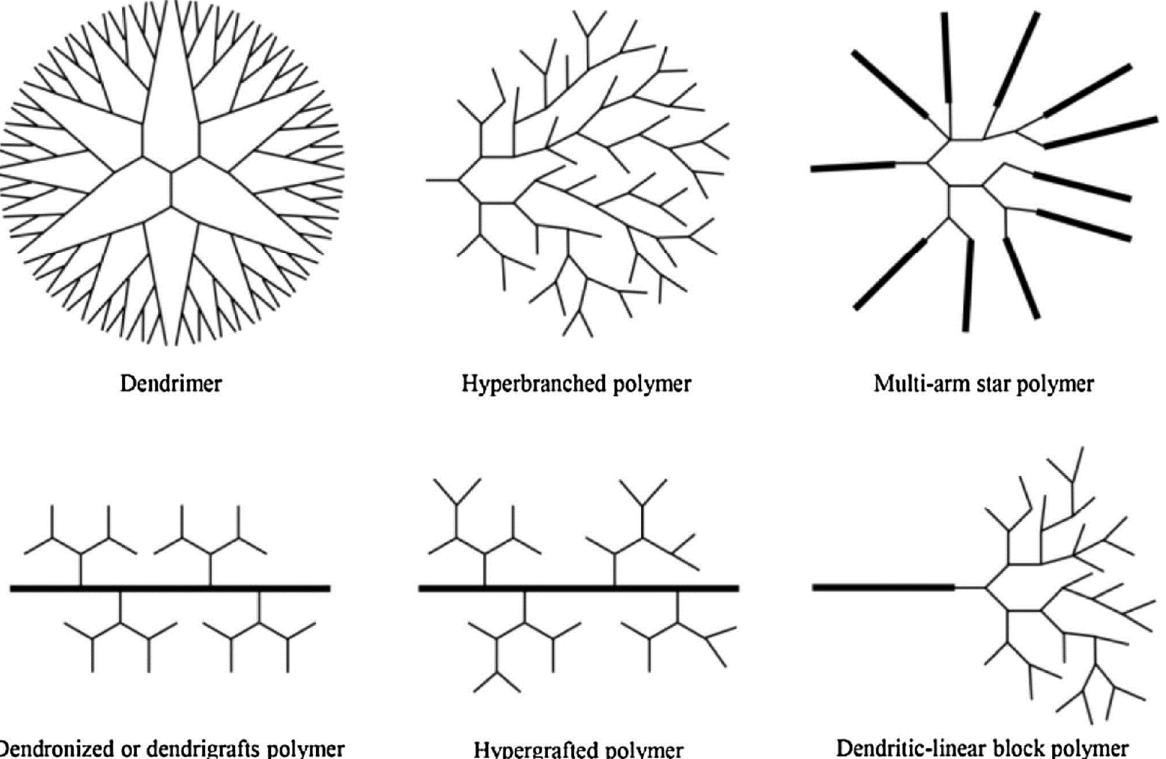
Figure 1. Six subclasses of dendritic polymeric material. Adapted with permission from Ma et al. [28]. Copyright (2016) Ivyspring International Publisher.